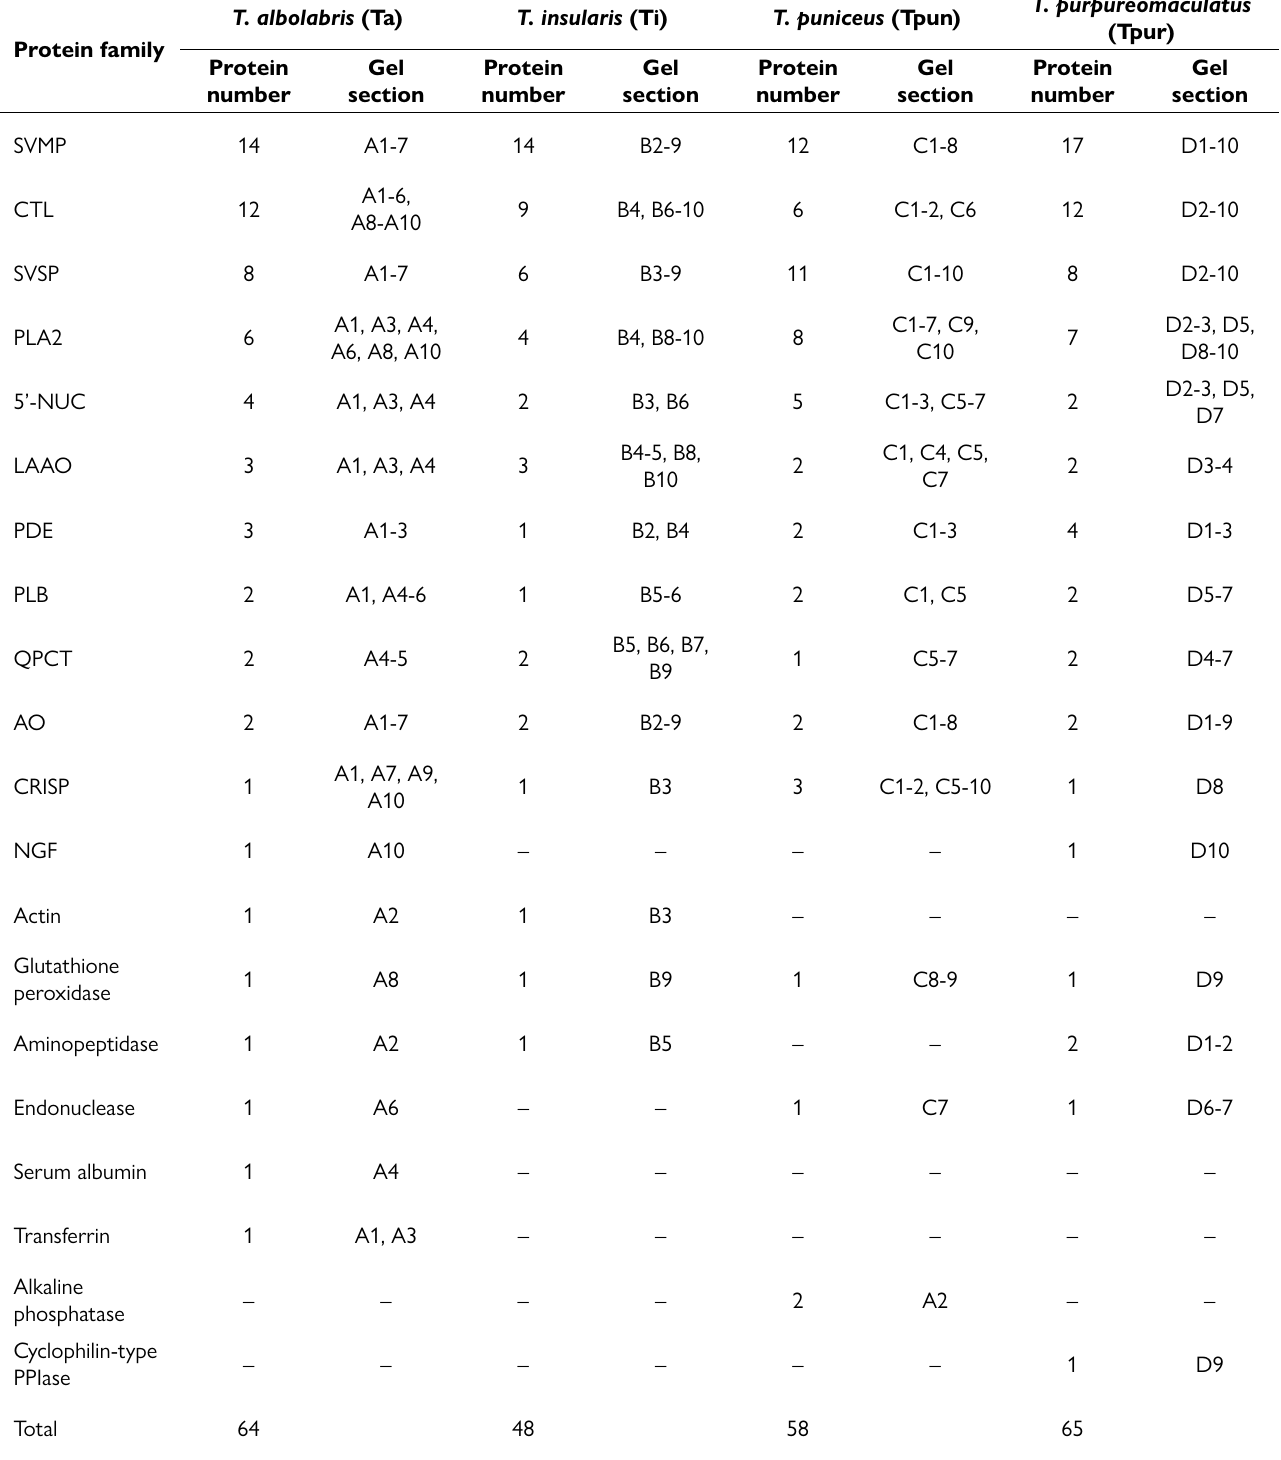
Table 1. Summary of protein families and the number of proteins identified from four Indonesian Trimeresurus